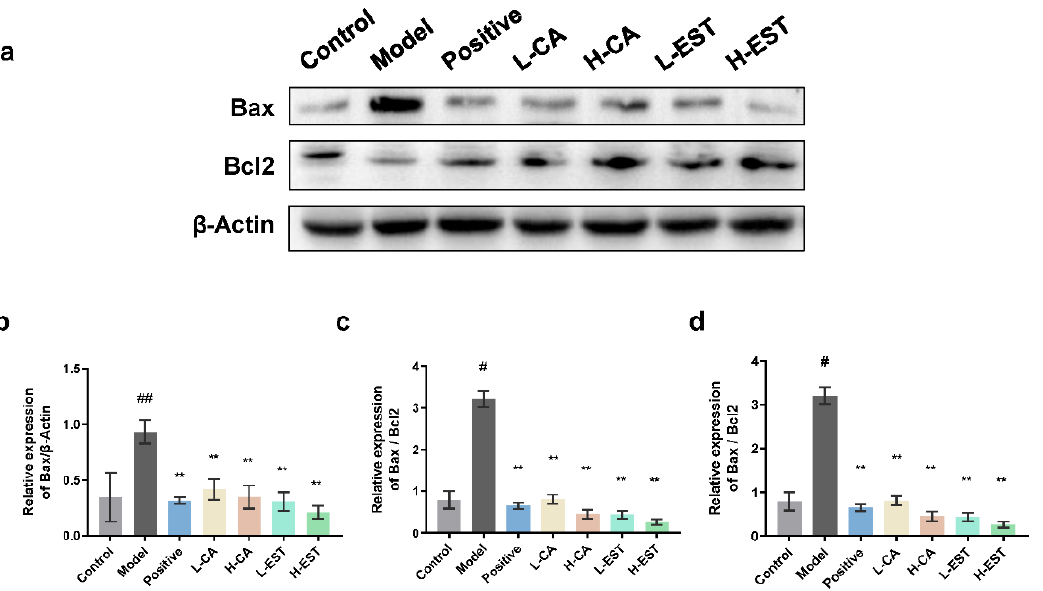
Figure 7. Effects of EST and CA on liver Bax and Bcl2 expression. ( a ) Western blotting analysis of Bax and Bcl2 expression in liver tissues and densitometric quantification of Bax ( b ), Bcl2 ( c ), and Bax/Bcl2 ratio ( d ), ( n = 3). Data are expressed as mean ± SD. # p < 0.05, ## p < 0.01 compared with the control group; ** p < 0.01 compared with the model group.